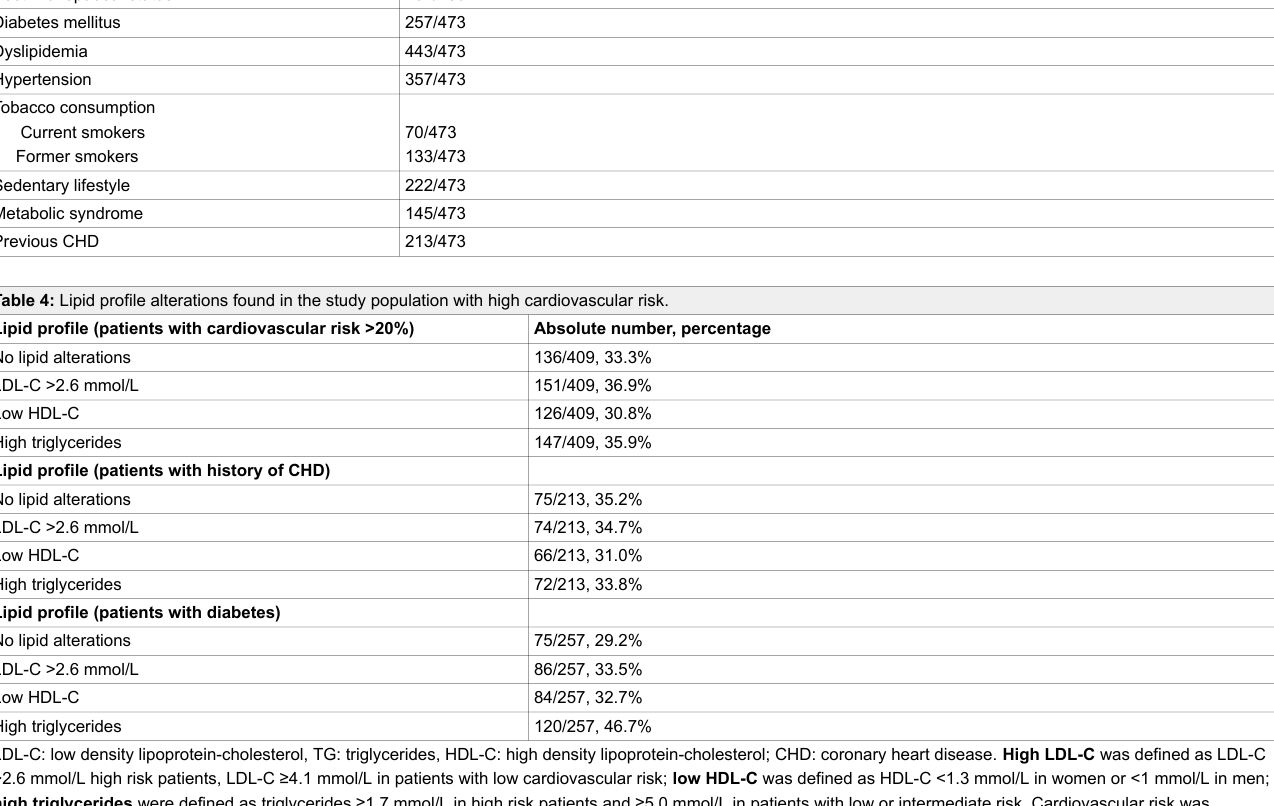
Table 3: Prevalence of cardiovascular risk factors in the study population.